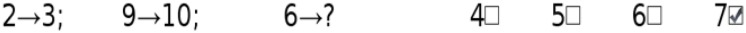
Inductive reasoning test.